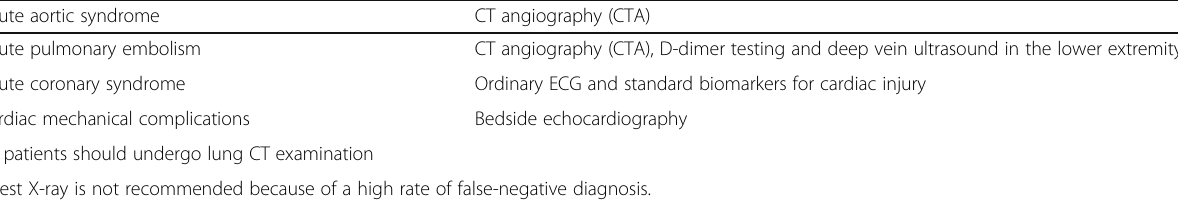
Table 2 Recommended investigations with definitive sensitivity and specificity for disease diagnosis or